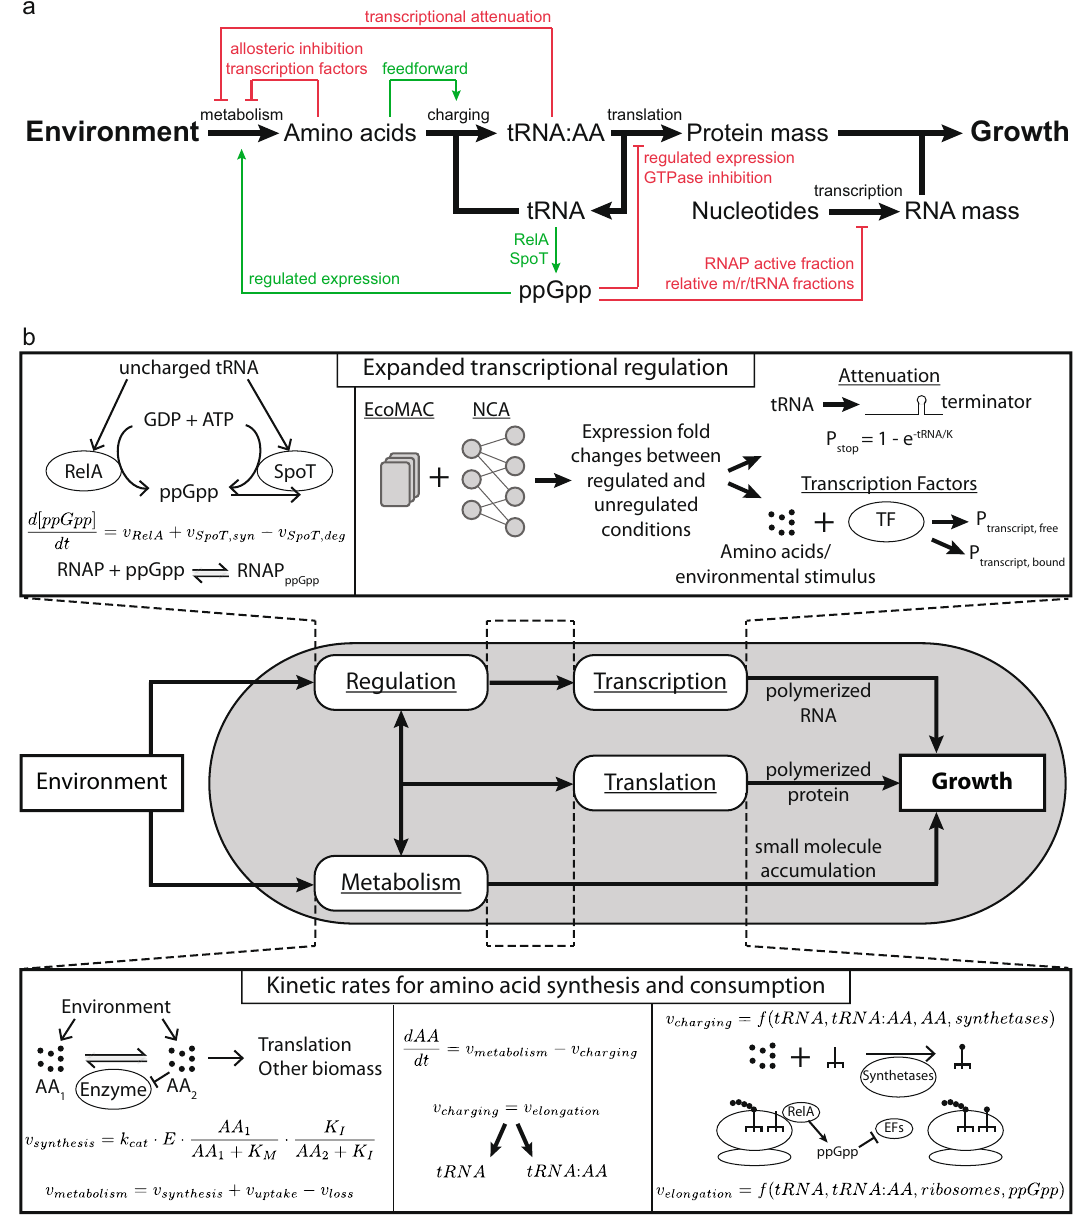
Fig. 1 A detailed, holistic model of growth rate control has been incorporated into the E. coli Whole-Cell Modeling Project. a A schematic representing biological functions and regulation that link the environment to growth. Black arrows represent mass fl ow, red arrows indicate regulatory inhibition and green arrows represent activation. b A schematic illustrating the integration of the biological functions in ( a ) in the context of the E. coli whole-cell model by including regulatory interactions and kinetic reaction rates. Such integration allows the growth rate to be determined by the simulation state, which is responsive to the simulated environment of interest. Dashed lines represent the link between the new mathematical representations and existing modeling processes that were modi fi ed. The resulting model includes more gene functions, accounts for the action of more small molecules, and can accommodate simulations in more